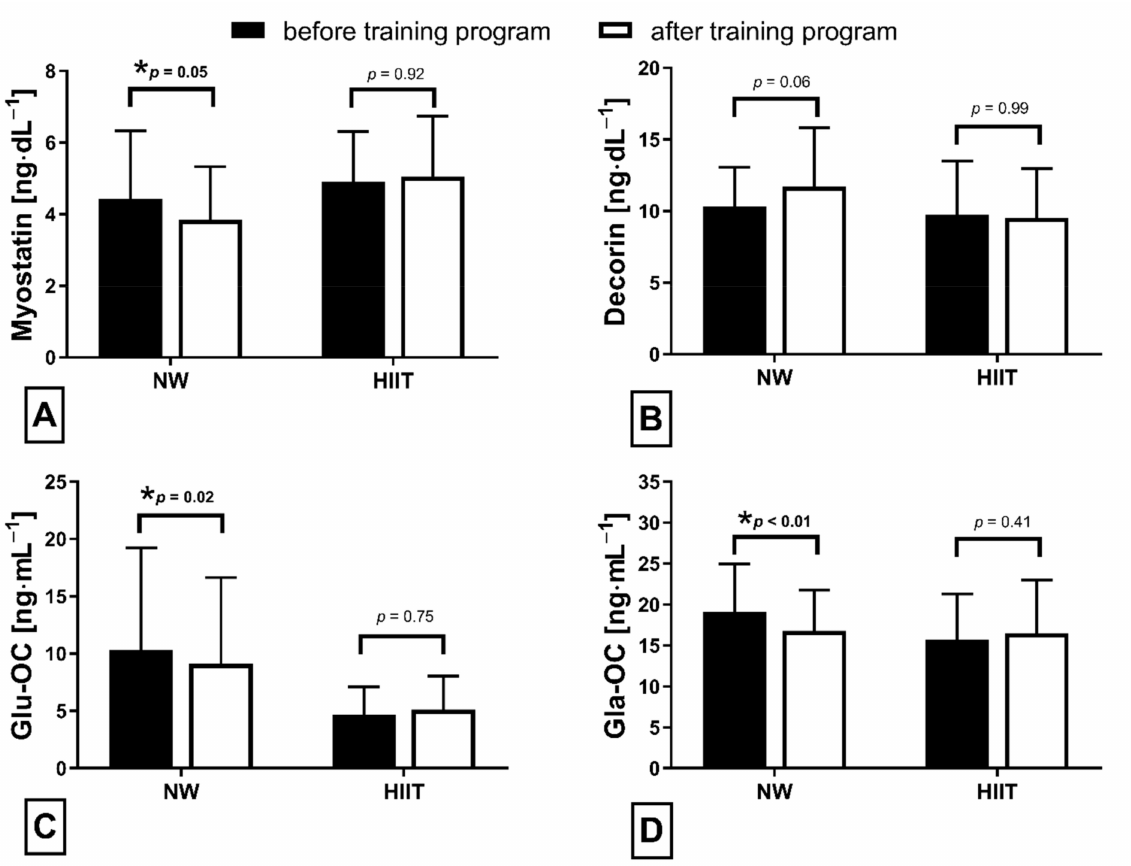
Figure 1. Myokines ( A , B ) and osteokines ( C , D ) concentration changes in response to applied training protocols: Nordic walking (NW; n = 18) and high intensity interval training (HIIT; n = 14). Data are presented as mean ± SD; * statistically significant result (post hoc tests); Glu-OC—undercarboxylated osteocalcin; Gla-OC—carboxylated-type of osteocalcin.